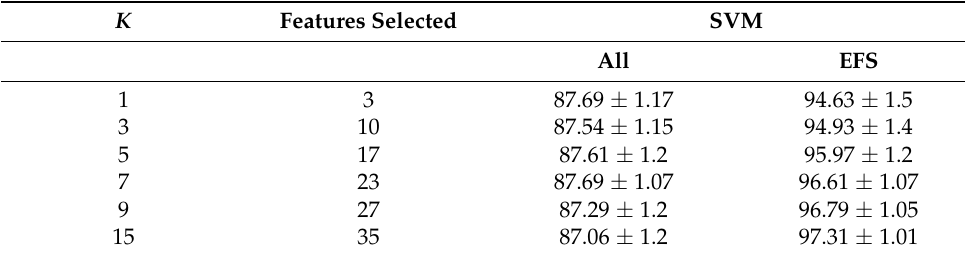
Table 4. Accuracy results—SVM.